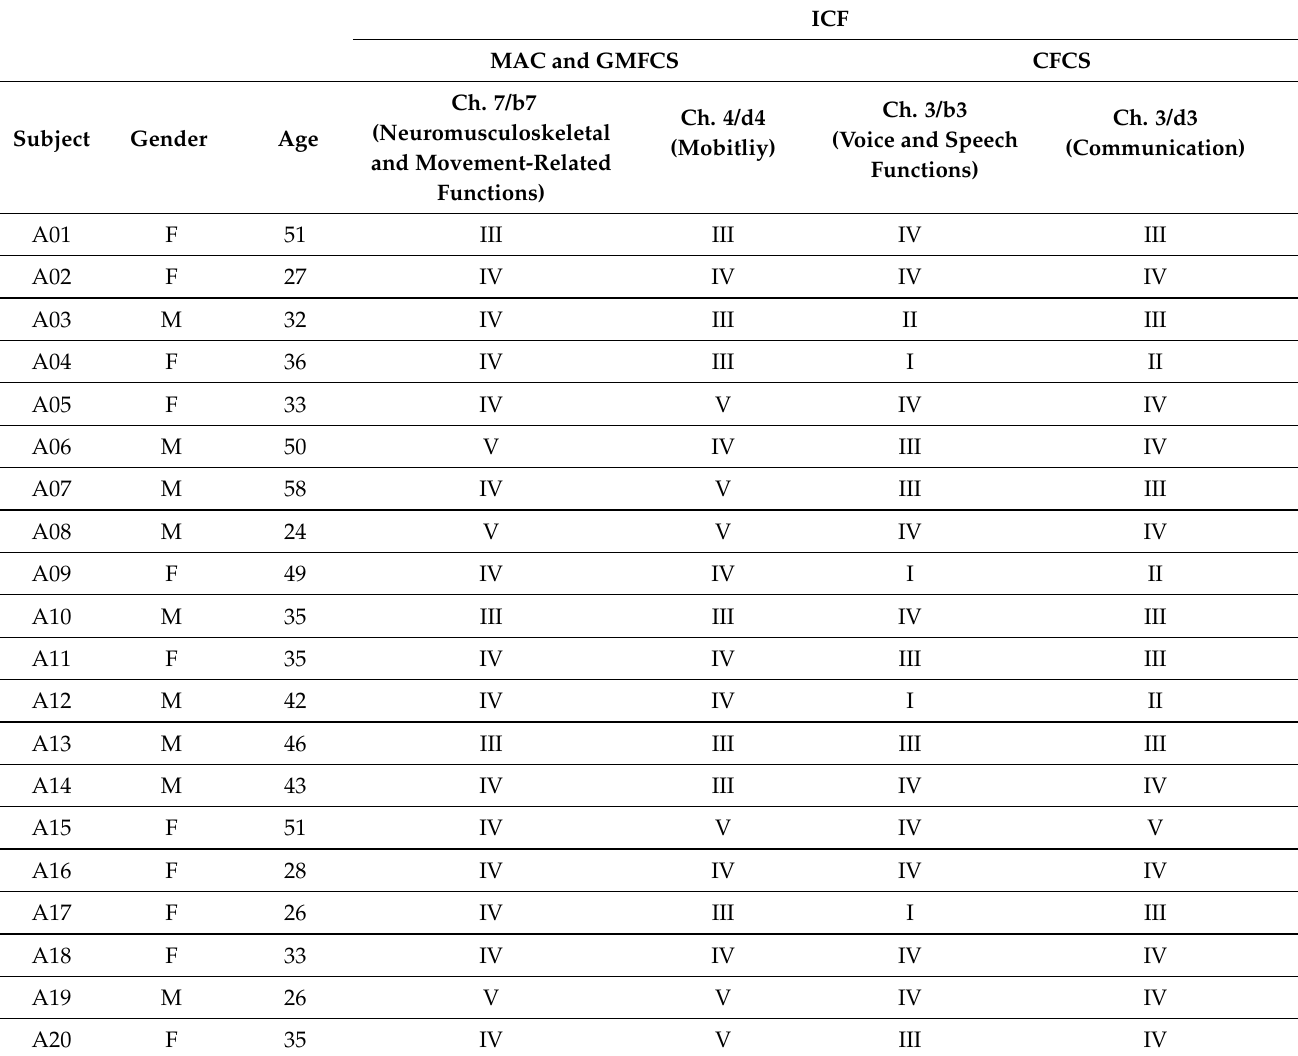
Table 3 shows the description for the adult population. Each item consists of a five-level Likert scale, whose values are shown in Roman numerals, following the same representation. People included in the study had severe affectations in their mobility and neuromuscular functions, since the values shown in columns (chapter 7/b7) and (chapter 4/d4) are all equal to or higher than III. In particular, 65% and 85% of participants scored IV and V in chapter 4/d4 and chapter 7/b7, respectively. Table 3. Adult Assessment according to ICF scale used in ASPACE, including gender and age. A 5- level Lickert scale, whose values have been shown in Roman numerals, following the same representation than in Table 2, is used to assess the items